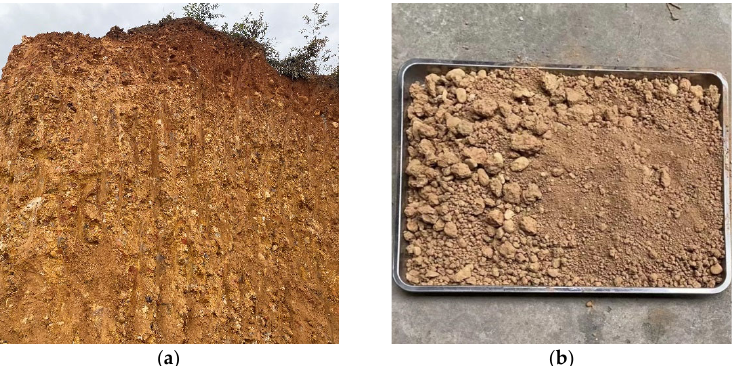
Figure 1. Glacial till. ( a ) Field sampling point of glacial till. ( b ) Laboratory sample of glacial till.